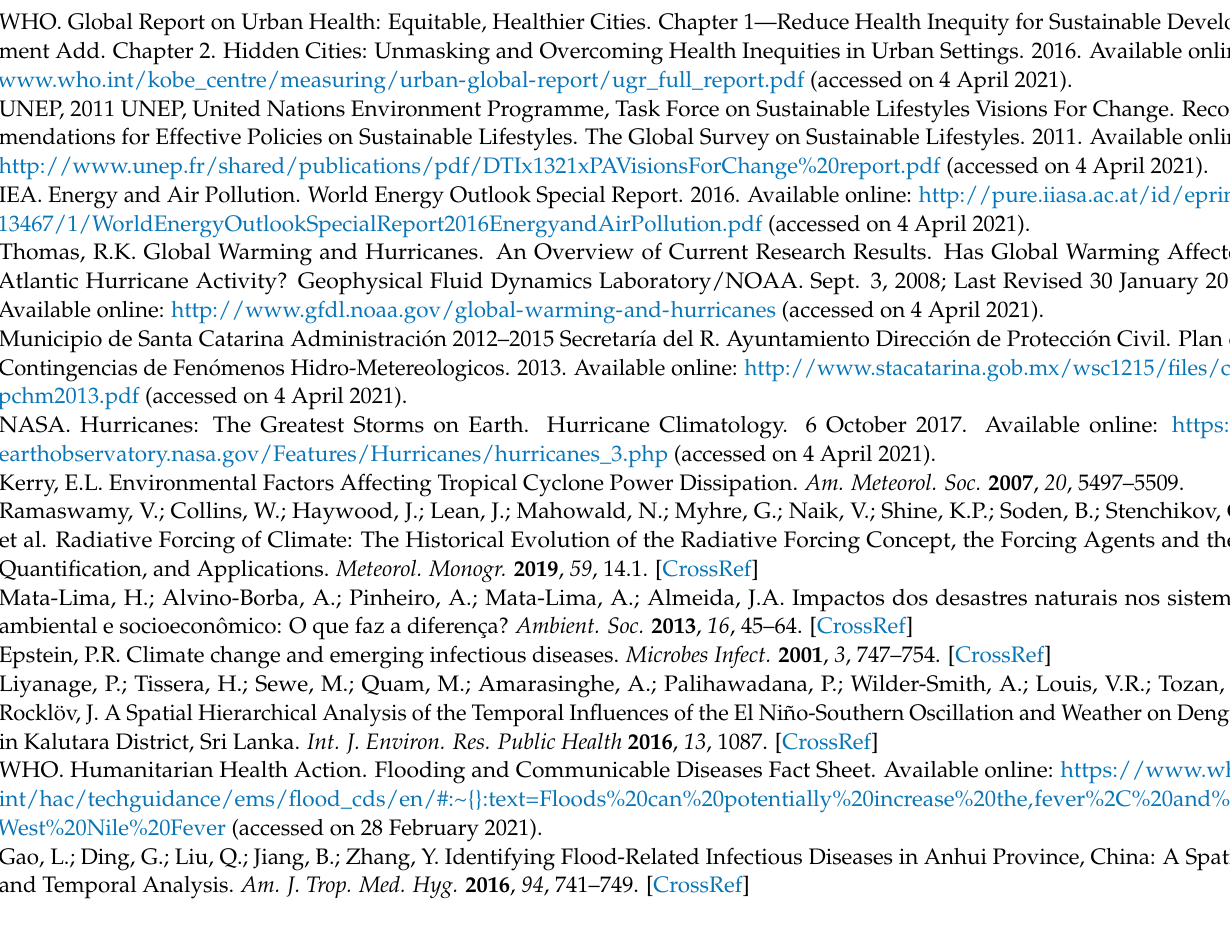
Figueroa Andere, M ó nica D á valos Tanaka, Nayely Leticia Jim é nez Tejeda, Omar Barcenas L ó